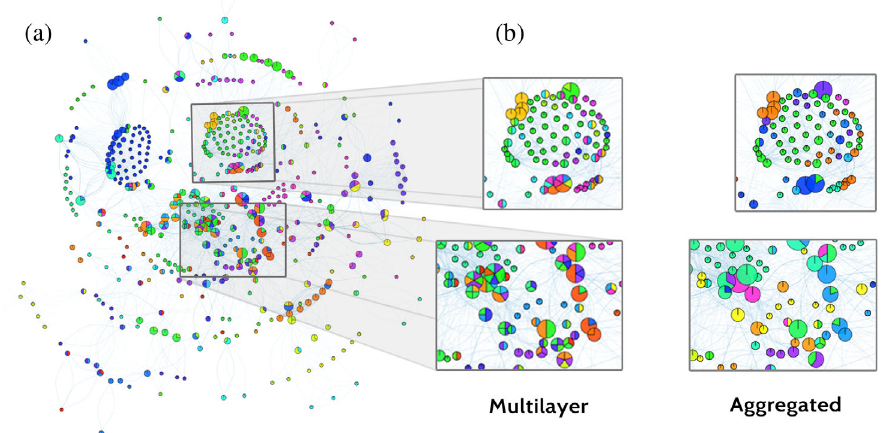
FIG. 4. Community structure in the Pierre Auger Collaboration network. (a) The overlapping community structure revealed by the multiplex map equation with relax rate r ¼ 0 . 15 . Nodes for scientists are colored according to their module assignments, with node sizes proportional to the number of tasks in which they were active. Specifically, the area of a colored pie-chart slice is proportional to the number of tasks in which the corresponding scientist is active. (b) Subsets of nodes with direct comparison with the overlapping community structure obtained from dynamics with r ¼ 1 . 0 .